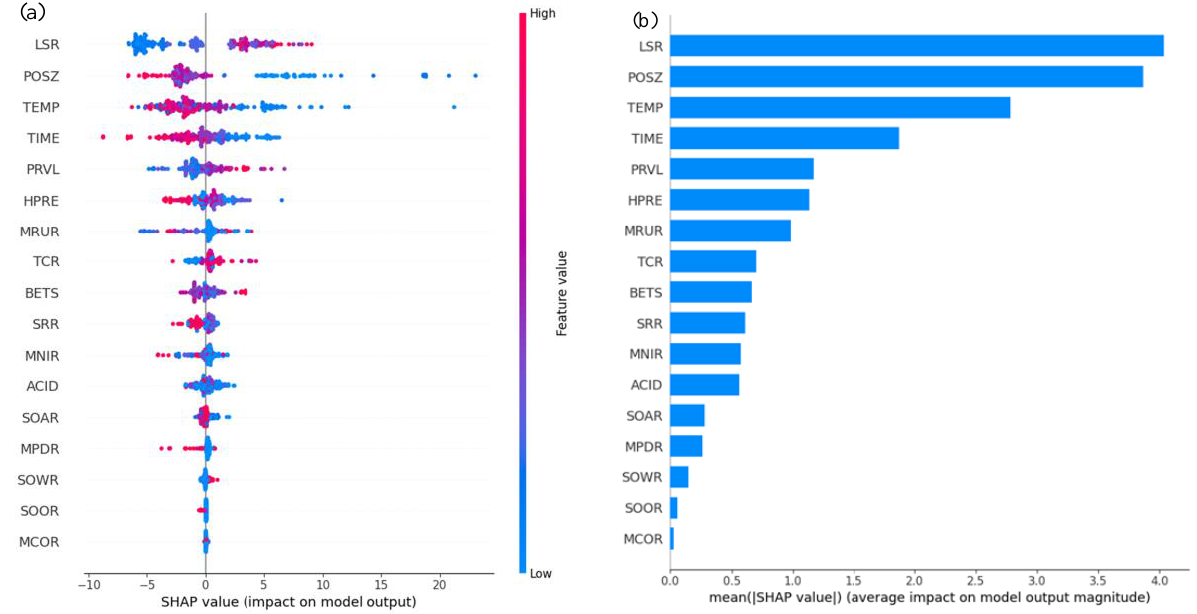
Figure 3. SHAP values (a) and feature importance (b) of XgBoost prediction on solid yield.